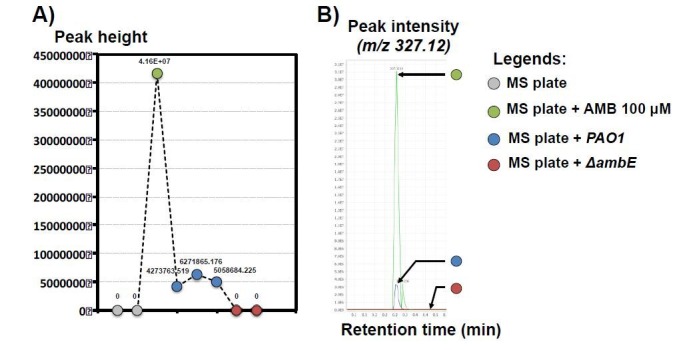
Identification of AMB in solid plate containing P. aeruginosa PAO1 by LC-MS/MS analysis.A) Peak height of AMB isolated from different solid plates as indicated in legends. Each dot represents a biological replicate. The different labels above represent the exact value for each replicate. B) Representative peak intensity of AMB feature (m/z 327.12) in a representative replicate. Note that AMB signal in plate containing PAO1 growing bacteria is ≈7-8 fold lower compared to the control plate containing 100 μM AMB.